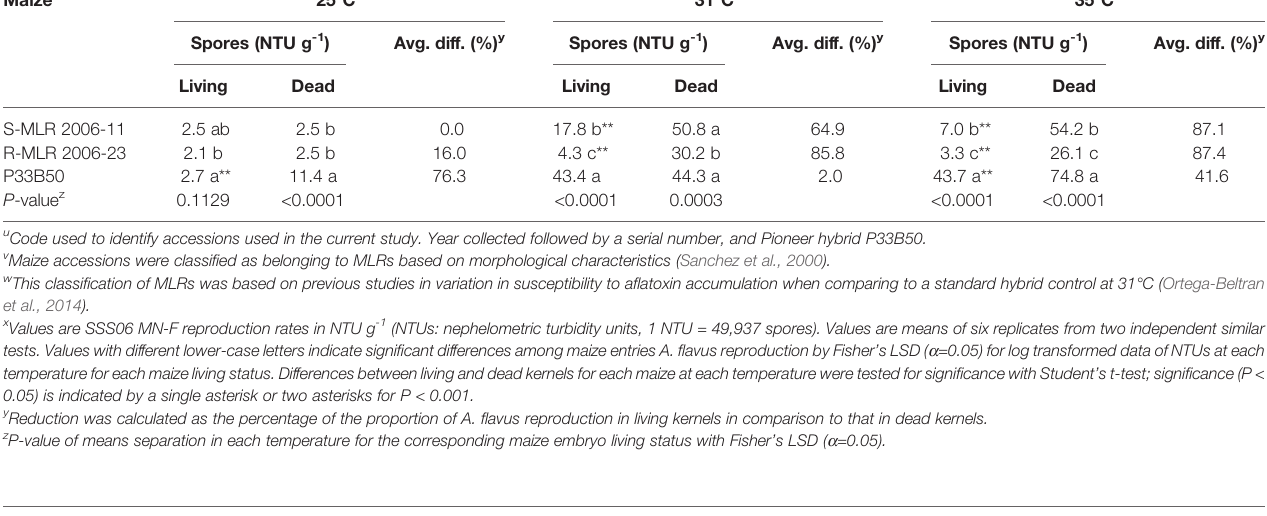
TABLE 5 | Comparison of Aspergillus fl avus SSS06 MN-F reproduction in living versus dead kernels of two native maize landrace (MLR) accessions and a commercial hybrid at three different temperatures. Maize